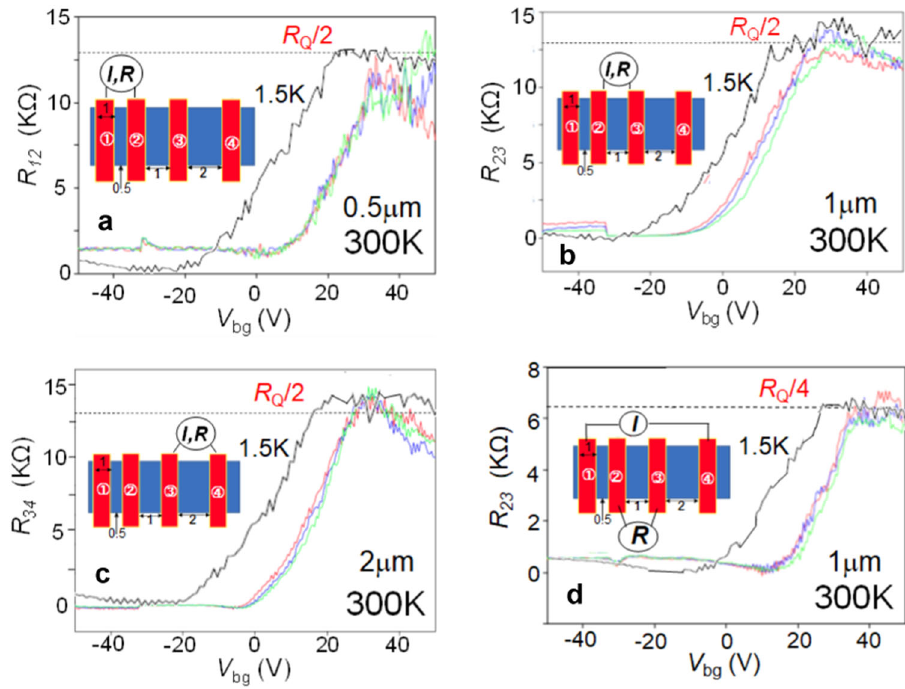
Fig. 2 Room-temperature resistance near R Q /2 and R Q /4. a – c Two- and d Four-probe resistance ( R ) measurements as a function of back-gate voltage ( V bg ) for the device shown at the bottom of Fig. 1g under a constant current of 1 μ A. The low contact resistance at the metal electrodes/the 1T ′ region interface is subtracted. Different colors of the three curves represent different measurements over time. Dotted lines correspond to R Q /2 and R Q /4, respectively. Black curves are the results measured at 1.5 K. Insets: schematic views of the electrode probe arrangement (red areas) on the 1T ′ region (in blue, corresponding to the part indicated by an arrow in Fig. 1g) with inter-probe (channel) distance expressed in μ m. Peaks or plateau-like features with values ∼ R Q /2 appear in all the two-probe measurements (Fig. 2a – c), which is consistent with a previous report of quantum spin Hall (QSH) phase in a short-channel monolayer of WTe 2 . This result is further con fi rmed in Fig. 2d with a value of R Q /4, which has been reported in QSH phase for the H -letter like patterns using four electrode probes on HgTe/(Hg, Cd)Te quantum wells, our Bi 2 Te 3 -nanoparticle decorated graphene, and in our previous high-power laser-irradiated thin 1T ′ MoS 2 . A straightforward calculation based on the Landauer-Büttiker formalism for Fig. 2d recon fi rms presence of the QSH